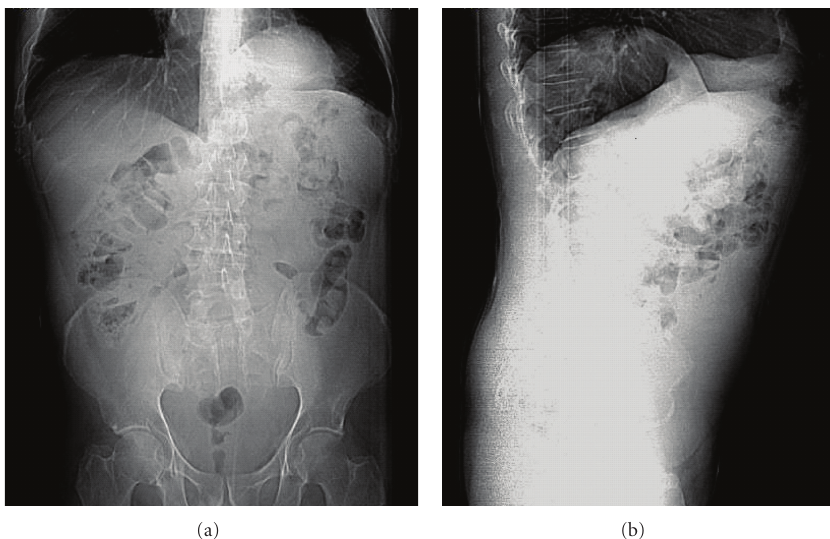
Figure 1: Abdominal X-ray showed a dilated loops of the colon above left hemidiaphragm.